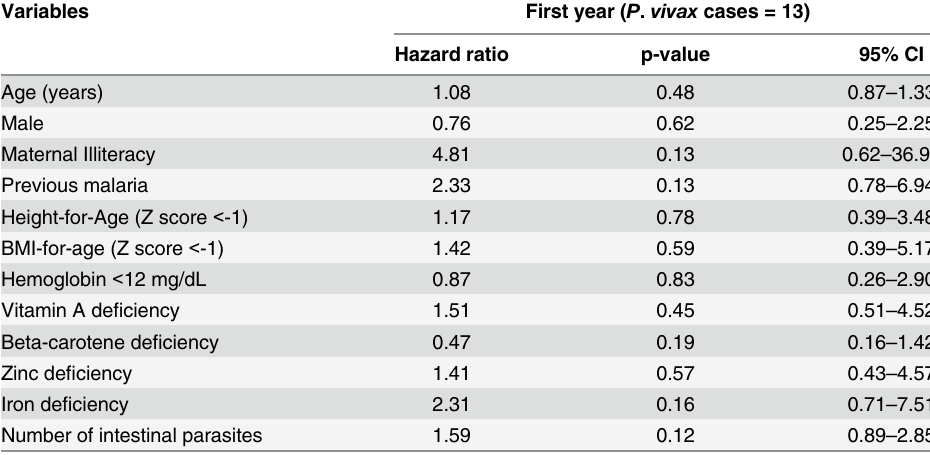
Table 2. Univariate Cox Proportional Hazard analyses of baseline characteristics associated with time to malaria incidence in Careiro, Brazil, May 2010.